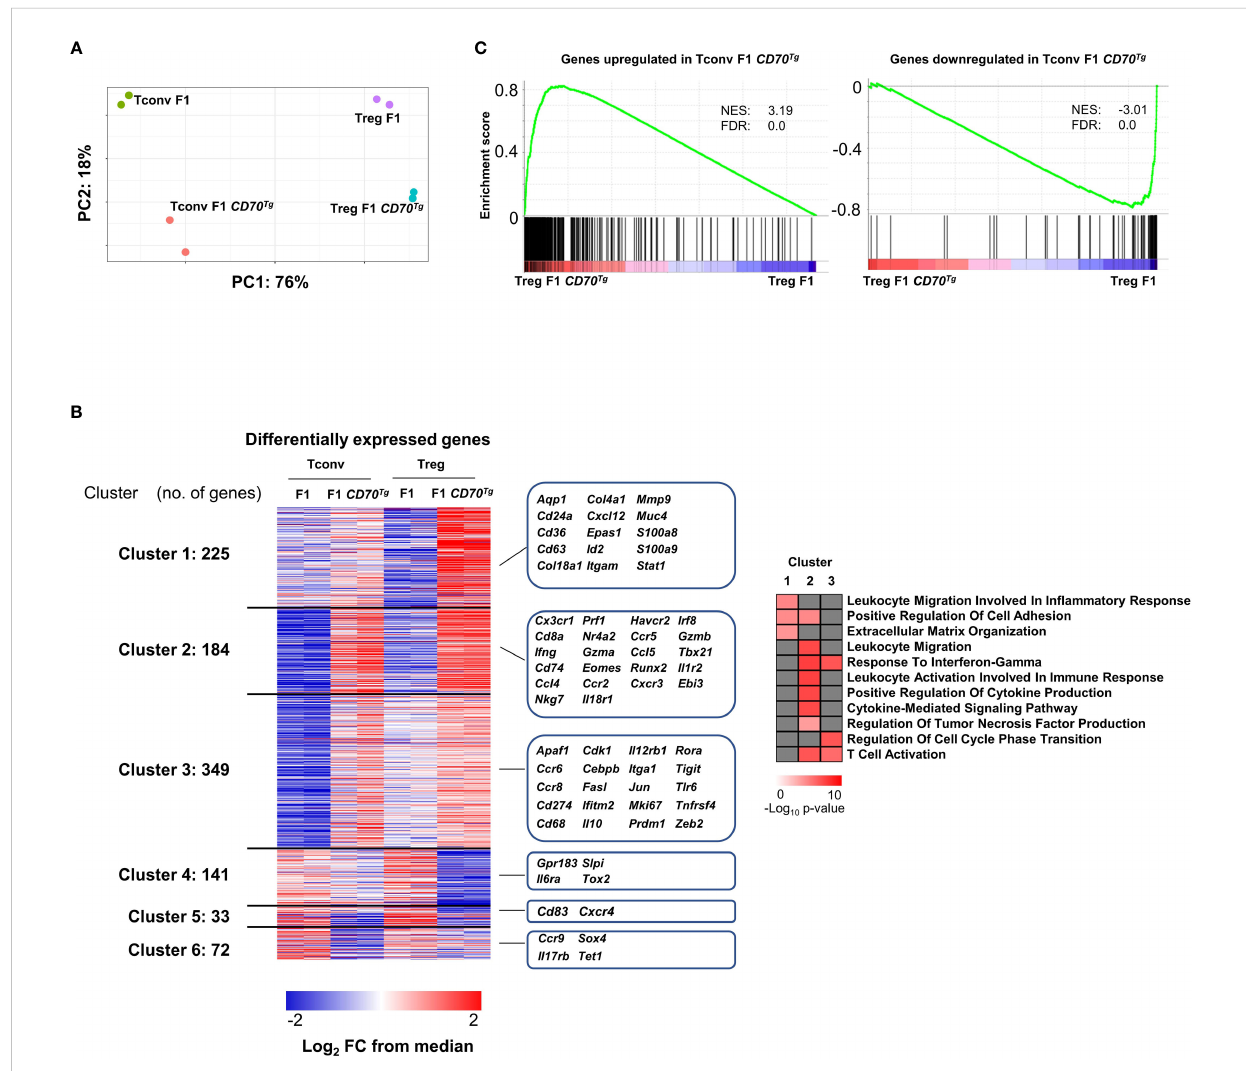
FIGURE 6 Common transcriptional signature of CD27 engagement in Tregs versus Tconvs. (A) Left panel: principal component analysis (PCA), a dimensionality reduction method, show the separation among Tregs and Tconvs due to CD70 Tg . Variance in PC1 and PC2 is shown. (B) Left panel: differentially expressed genes of Tconvs and Tregs are clustered based on occurrence. Clusters 1 and 3 are upregulated speci fi cally in Treg F1 CD70 Tg and Tconv F1 CD70 Tg , respectively, whereas clusters 4 and 6 consist of genes downregulated speci fi cally in Treg F1 CD70 Tg and Tconv F1 CD70 Tg , respectively. Shared up/down regulated genes are found in cluster 2 and 5. Values are represented as Log2 fold-change obtained from median CPM of each gene. Selected genes for each cluster are displayed in the right margin. The number of genes in each cluster is shown in the left margin. Right panel, selected pathways enriched in clusters 1, 2, and 3 using clusterPro fi ler R package with default parameters and presented as − Log 10 of p-value. (C) GSEA performed on F1 CD70 Tg data set and Tconv F1 CD70 Tg differentially expressed genes as gene sets. Normalized enrichment score (NES) and false discovery rate (FDR) are indicated. F1 mice: CD27 +/- ; F1 CD70 Tg mice: CD11c- Cd70 tg;CD27 +/-